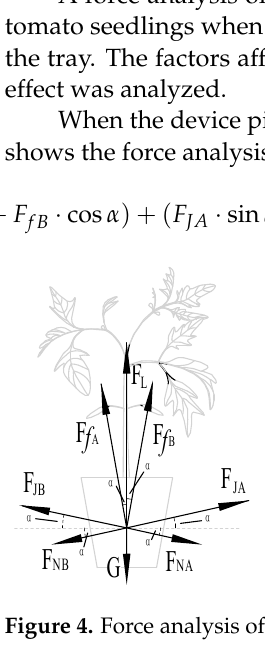
Figure 3. Procedure diagram of seedling picking.